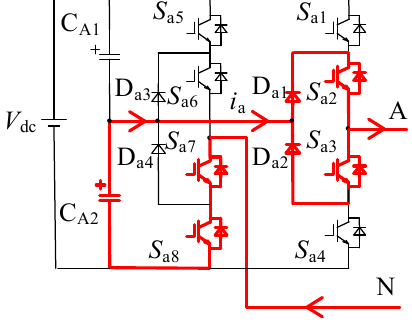
Figure 4. The circuit of pulse mapping 3. Table 2. Changes in midpoint potential in pulse mapping 2, 3, 7, and 8 with different direction currents.